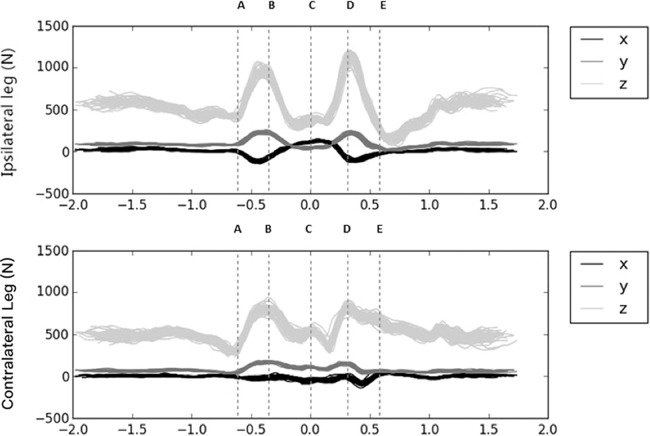
Typical three-dimensional GRF of the ipsilateral and contralateral legs for an 87 kg athlete.(A) midpoint (down), (B) lowest point (down), (C) end of back swing, (D) lowest point (up), (E) midpoint (up), x, medio-lateral; y, anterior–posterior; z, vertical.